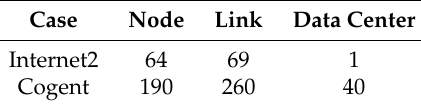
Figure 9. The topology of Internet2. Table 2. Properties of the